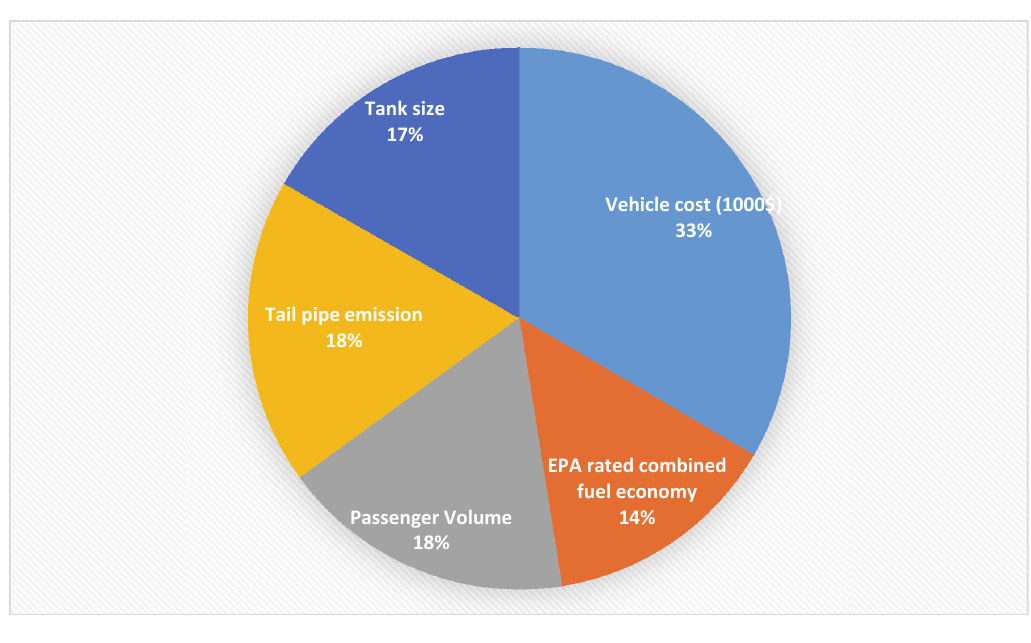
Fig. 1. Entropy based criteria